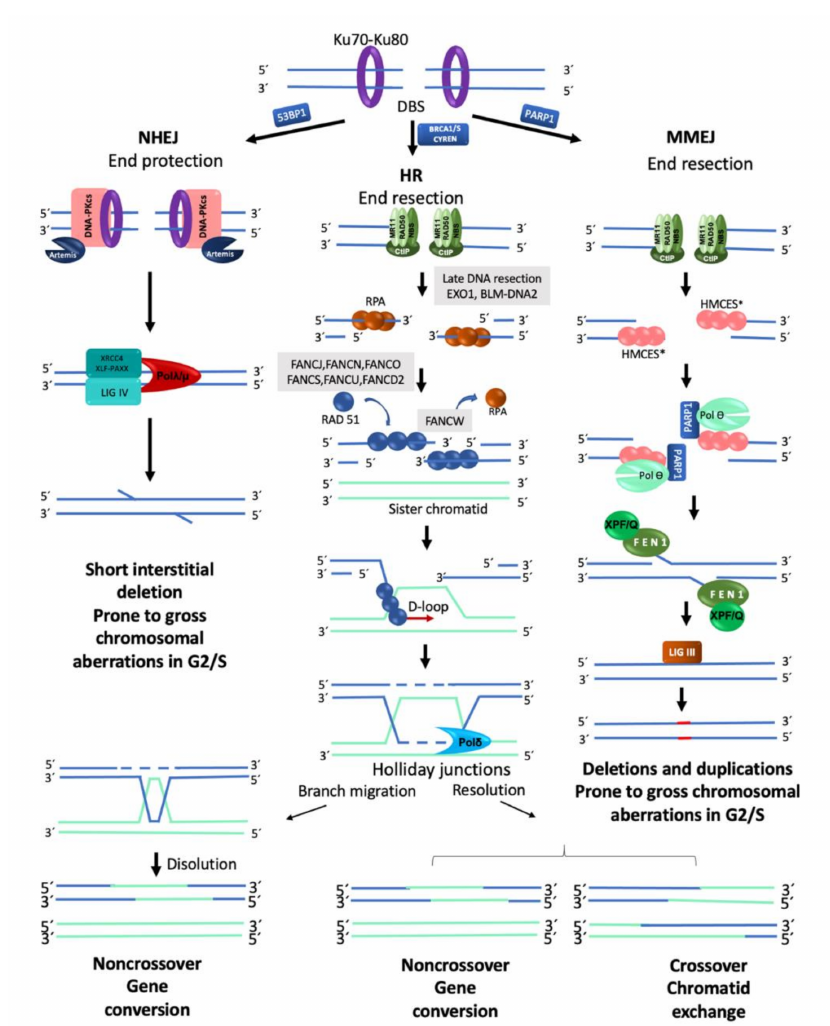
Figure 2. Major mechanisms of double-strand break repair. NHEJ, Non-Homologous End Joining. DNA ends are protected by KU70 / KU80, which prevents their end-processing. When the ends are incompatible, a segment of up to four nucleotides is detected, Artemis eliminates the remaining incompatible segments and ligation is carried out by LIGIV-XRCC4. This pathway can repair a DSB without chromosome modification; however, during S / G2 and in the presence of several DSBs, it is considered prone to generate chromosomal alterations. HR, Homologous Recombination. This pathway is only available during the S / G2 phases of the cell cycle since it requires a homologous template; HR is the best choice to maintain sequence fidelity because in general it repairs in an error-free manner. A ssDNA 3 (cid:48) overhang is produced by the action of the MRN-CtIP complex; it is first covered by RPA proteins which are later replaced by RAD51 to form the nucleoprotein strand that will carry out the invasion of the DNA of the sister chromatid in order to use it as a template to restore the continuity of the original nucleotide sequence. MMEJ, Microhomology-Mediated End Joining. PARP1 prevents KU70 / KU80 binding to DNA ends and allows the recruitment of MRN-CtIP to initiate end-resection, creating a short 3 (cid:48) overhang. This overhang is preferentially covered by HMCES which channels the damage to be repaired by MMEJ instead of HR. PARP1-POLQ search for microhomology of 2–20 bp and align the strands. The resulting flaps are eliminated by XPF / FANCQ-FEN1. Alternatively, POLQ can direct DNA synthesis to add nucleotides to make DNA ends compatible; this end processing generates in situ deletions and duplications. In addition, if this pathway is active during S / G2, and several DSBs coincide in time and space, gross chromosomal aberrations are formed because, similar to NHEJ, they do not require long stretches of homology to ligate the DNA ends [23,26]. * RPA or